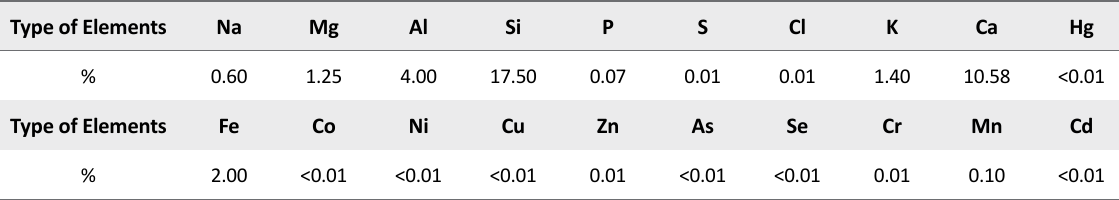
Table 5. Inductively Coupled Plasma (ICP) results of elements content in the investigated soil Type of Elements Na Mg